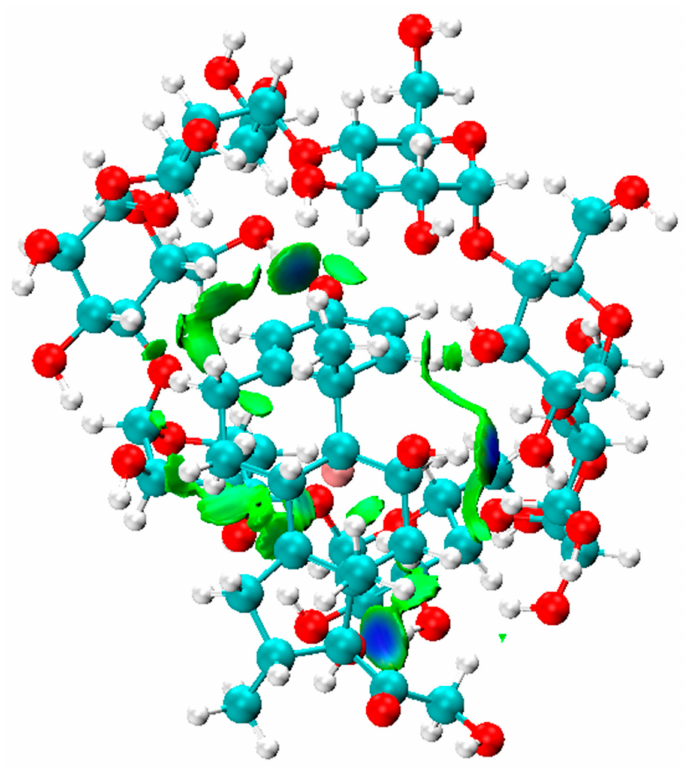
Figure 2. The IGM isosurface (isovalue = 0.006 a.u.) of the Dex@ β -CD complex.